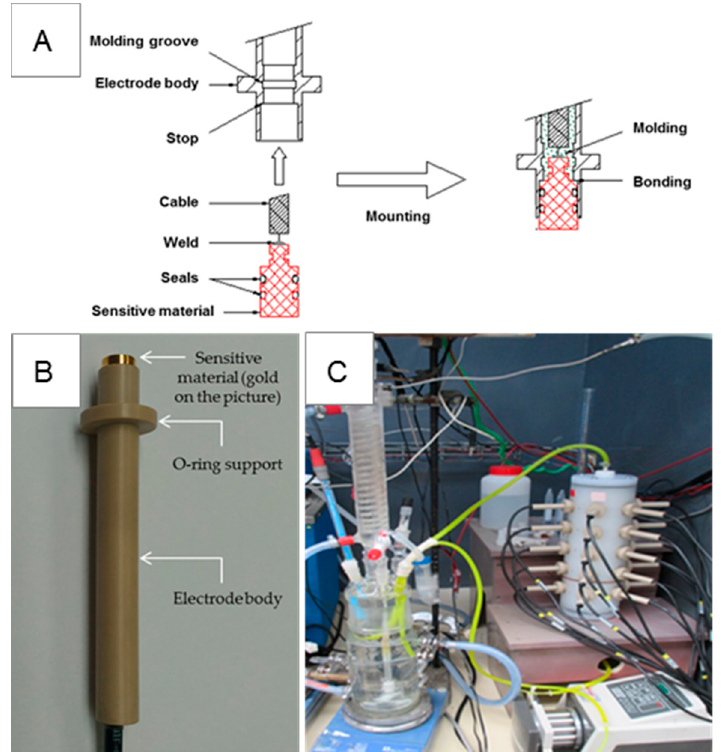
Figure 2. ( A ) Schematic representation of electrode construction; ( B ) Actual view of a gold-based electrode; ( C ) View of the entire experimental set-up.